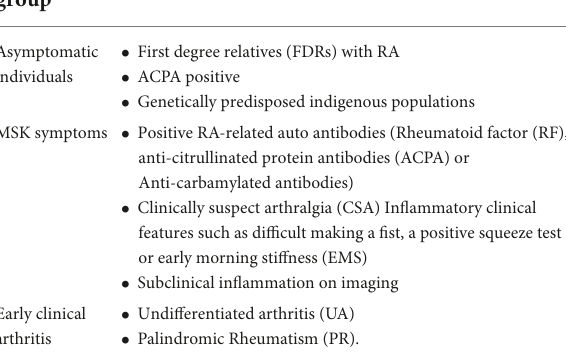
TABLE 1 EULAR defined populations at risk of developing